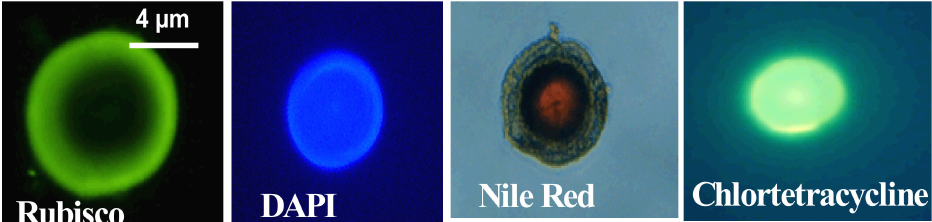
Figure 12. Fluorescence images show that marine gels contain a broad variety of biopolymers, in- cluding rubisco—a protein, labeled with a fluorescent specific antibody—nucleic acids—labeled with DAPI—hydrophobic moieties, probably lipids—labeled with Nile Red—and polyanionic polymers that bind Ca—labeled with CTC